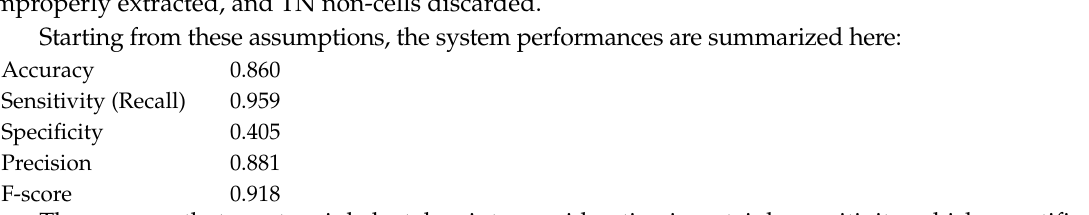
Figure 12. Cell Figure 12. Cell detection. Table 1. Cell detecting performance.